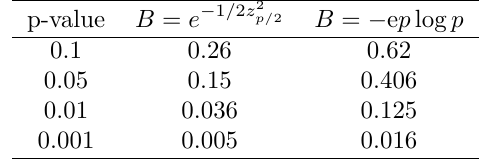
Values of B in the light of different p-values (Goodman,